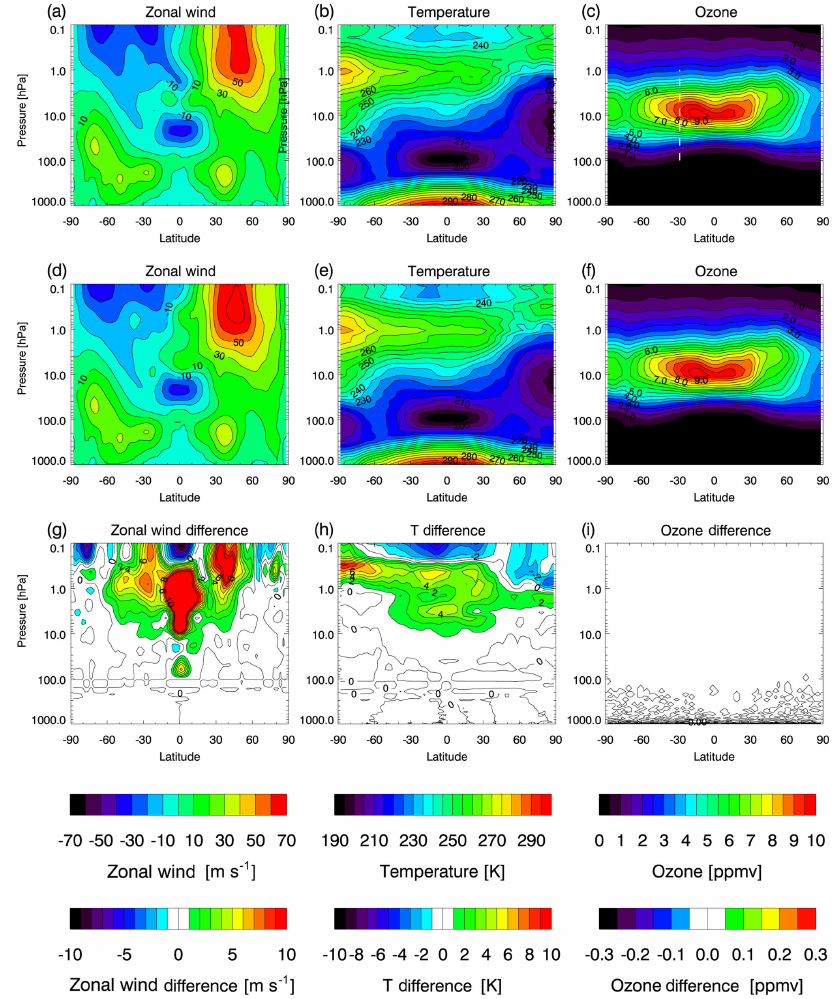
Figure 4. Analyses for 15 November 2014 (00:00Z). Zonal mean zonal wind (ms − 1 ) for the (a) truth experiment and (d) baseline ex- periment and (g) baseline–truth zonal wind difference. Zonal mean temperature (K) for the (b) truth experiment and (e) baseline experi- ment and (h) baseline–truth temperature difference. Zonal mean ozone (ppmv) for the (c) truth experiment and (f) baseline experiment and (i) baseline–truth ozone difference. Color bars are provided for zonal mean quantities and differences. Red (blue) indicates high (low) values for each quantity. The white dashed line in panel (c) indicates latitude of 28.6 ◦ S, which is the central latitude of the cross-correlations examined in Sect.